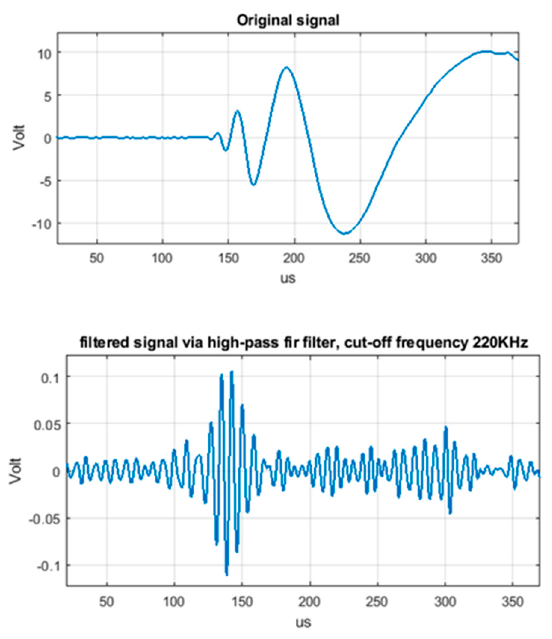
Figure 7. ( Top ) Original signal; ( Bottom ) high pass digitally FIR filter with cut-off frequency 220 kHz.